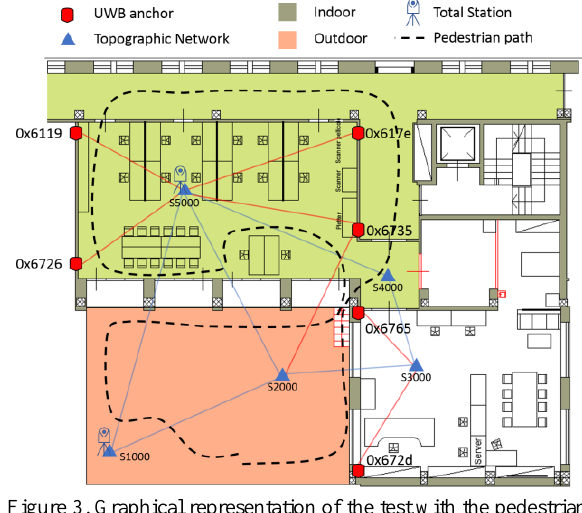
Table 3. Data provided by Stencil 2 MMS.